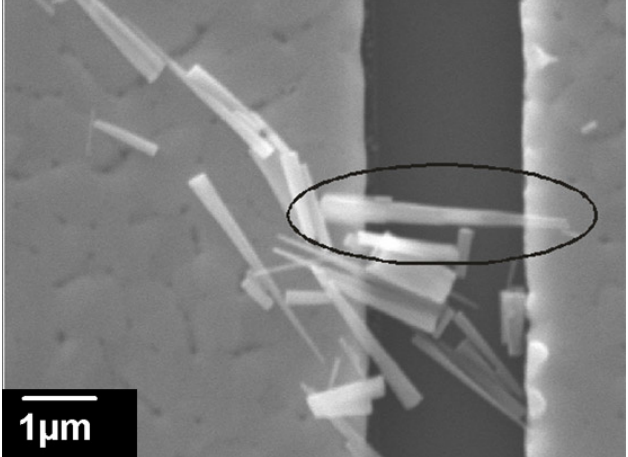
Figure 5. CL spectra measured on an individual NR in the temperature range from 90 to 300 K. In the inset, the SEM image of NR studied is shown.